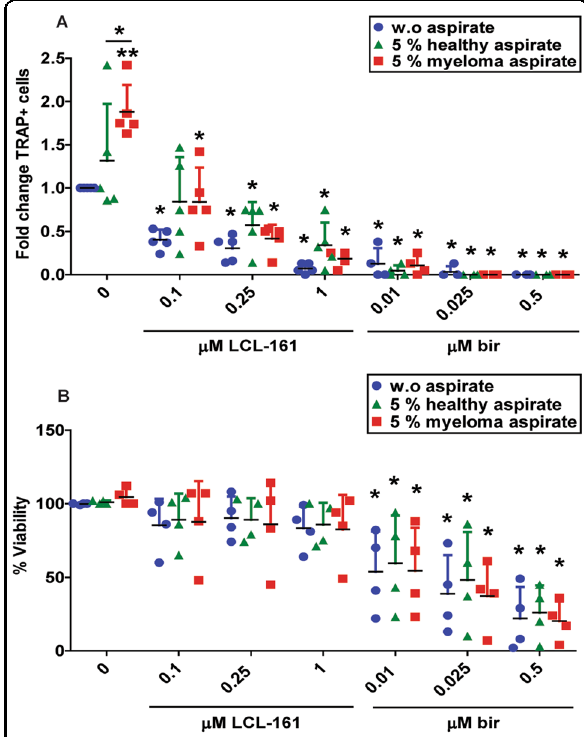
Fig. 5 SM blocks myeloma bone-marrow aspirate-driven osteoclastogenesis. Human CD14 + monocytes were differentiated in OC differentiation medium supplemented with 5% bone-marrow aspirate from myeloma patients or healthy controls and treated with LCL-161 or birinapant at indicated concentrations throughout OC differentiation. TRAP + cells with 3 or more nuclei were counted as OC and represented as fold change of TRAP + cells as compared to no aspirate (w.o. aspirate) ( A ). Results are from 5 donors, mean and SD are indicated. Cell viability was measured by the Cell Titer Proliferation Assay ( B ). Results are from 4 donors, mean and SD is indicated. Single asterisk denotes statistical signi fi cance as compared to the untreated control within each group or between indicated groups. Double asterisk denotes statistical signi fi cance as compared to untreated control w.o aspirate ( p < 0.05, One-way